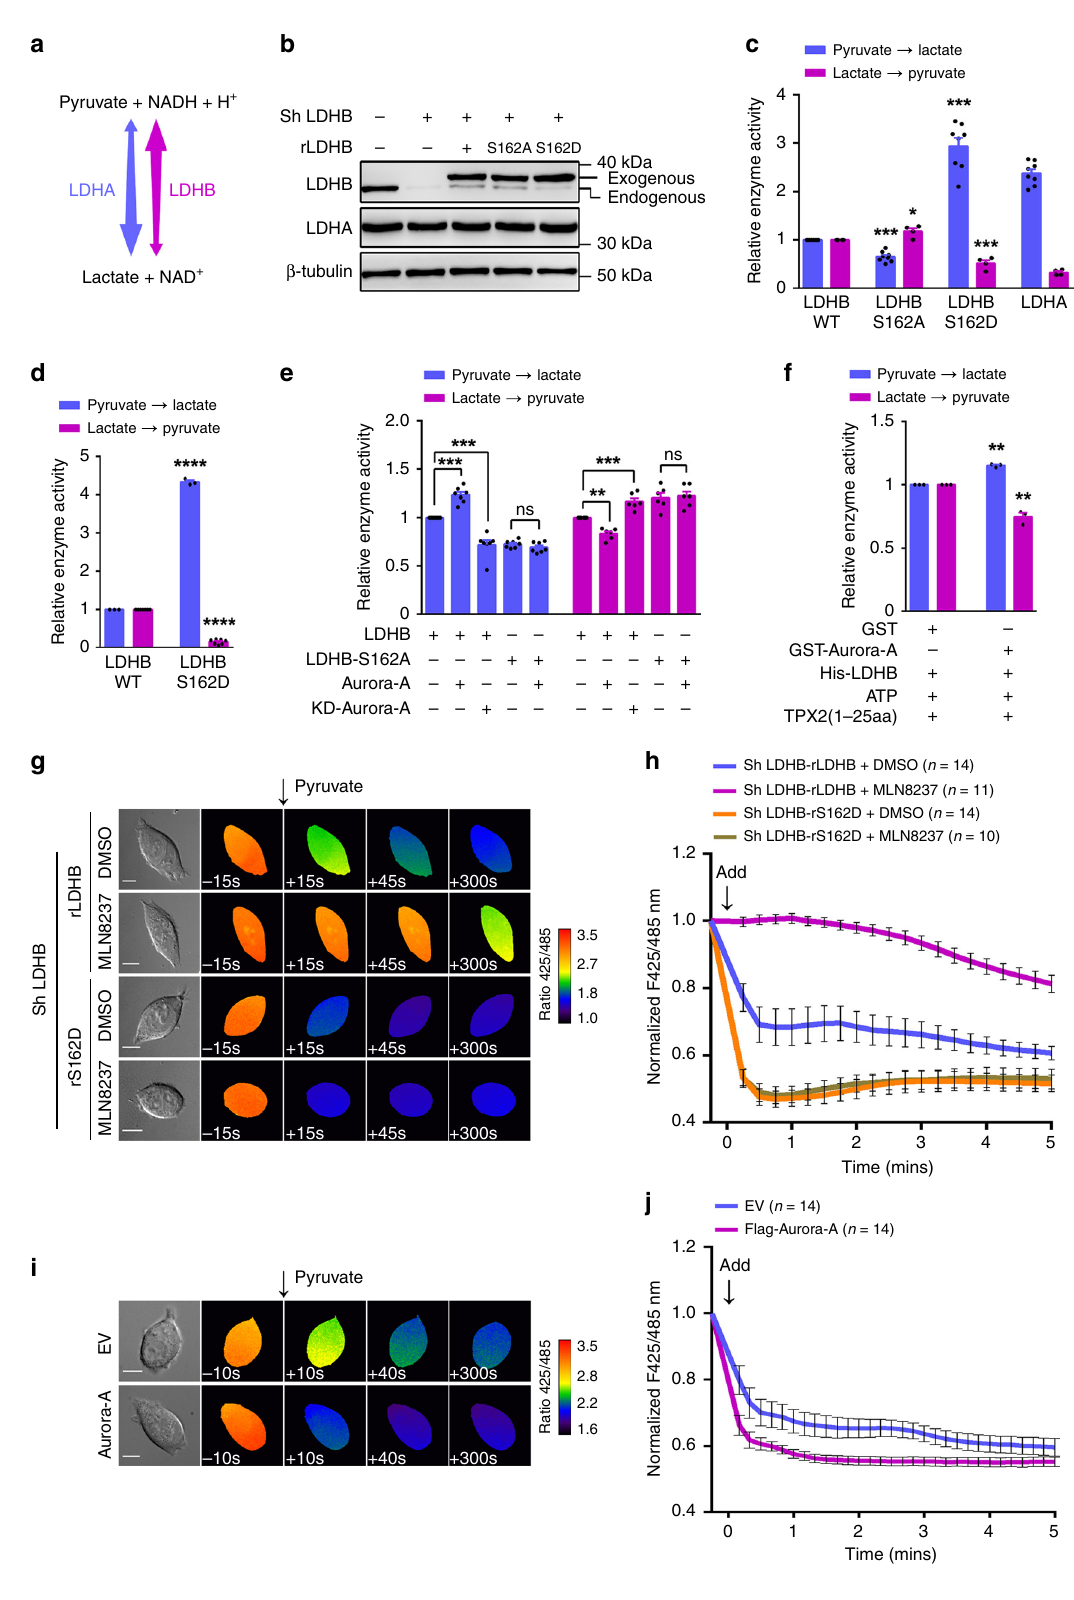
(Fig. 5a, b), the non-phosphorylated mutant LDHB-S162A S162D increased the glycolytic fl ux (Fig. 5c, d). Moreover, expressing cells showed a decreased glycolytic rate (Fig. 5c, d). Aurora-A inhibition reduced the glycolytic fl ux in LDHB-WT- This decrease could be ascribed to the reduction in LDH activity expressing cells, but not in LDHB-S162D-expressing cells, con- fi rming that phosphorylation of S162 was required for Aurora-A of forward reaction because additional expression of LDHA fully rescued the glycolytic rate (Fig. 5c, d). In contrast to S162A, mediated regulation of LDHB in glycolysis (Fig. 5e, f). NATURE COMMUNICATIONS| (2019) 10:5566